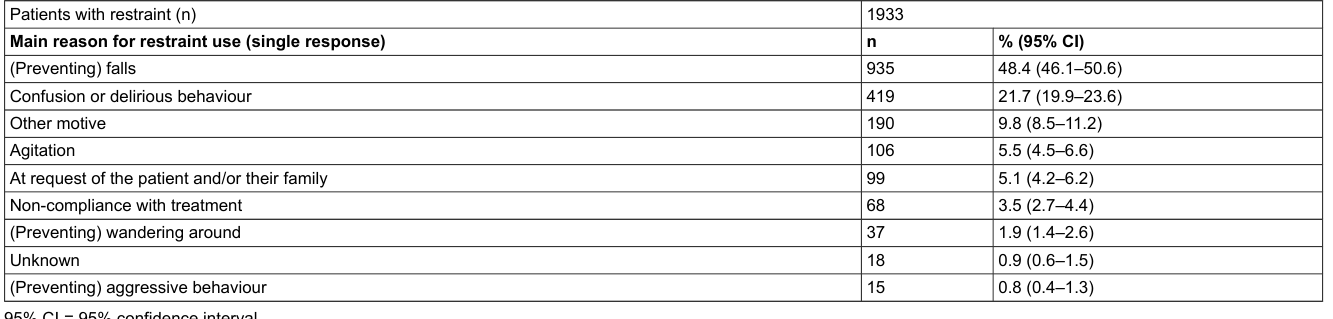
Table S4: Reasons for restraint use.